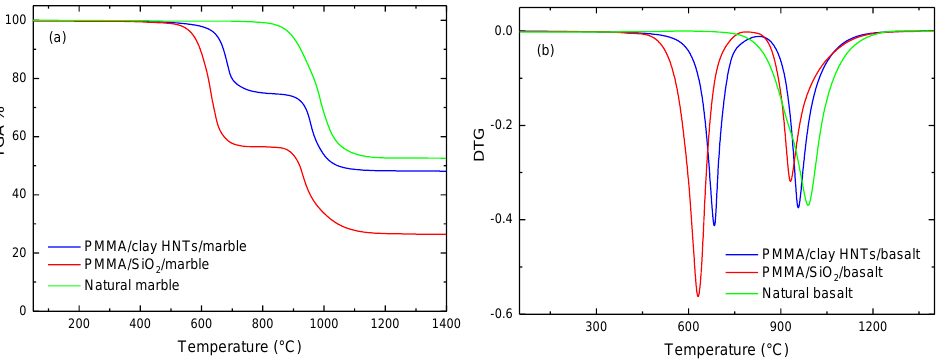
Figure 9. Effect of nanofiller type on thermogravimetric analyzer (TGA) ( a ) and derivative of the thermograms (DTG) ( b ) curves of marble solid surface nanocomposites (compared to natural marble).